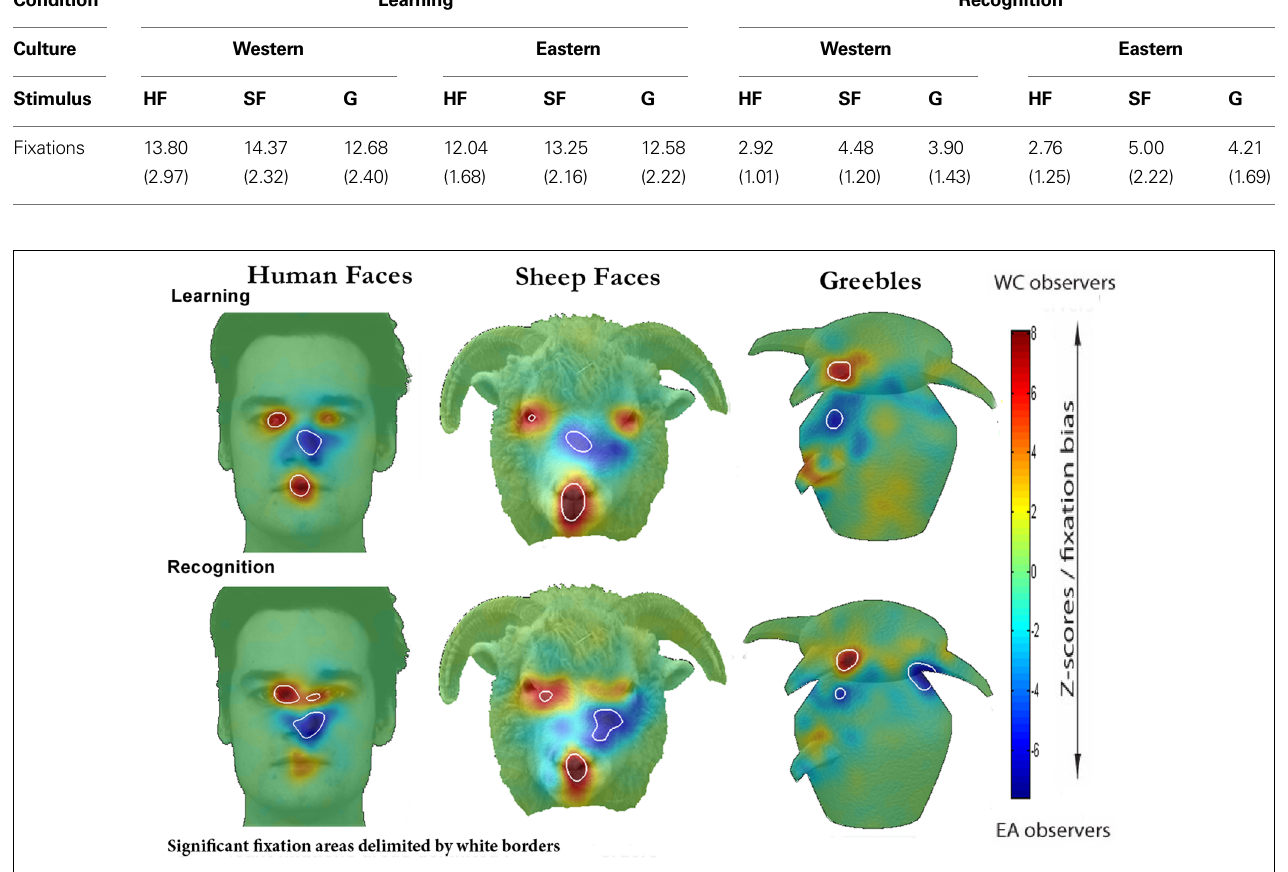
FIGURE 2 | Fixation maps for WC and EA participants for all stimulus conditions.